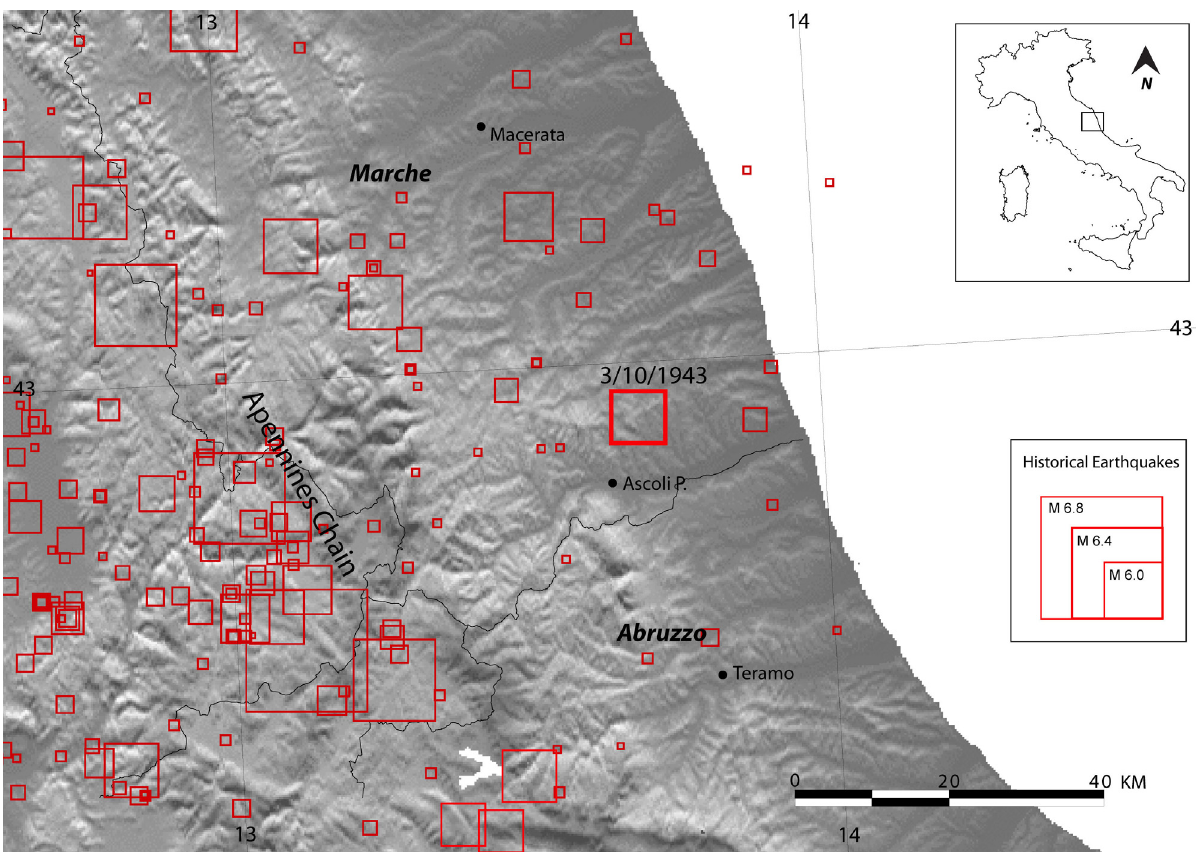
Figure 1. Historical seismicity of central-eastern Italy from CPTI11 [Rovida et al. 2011]. The October 3, 1943, earthquake is indicated with a bold line square.